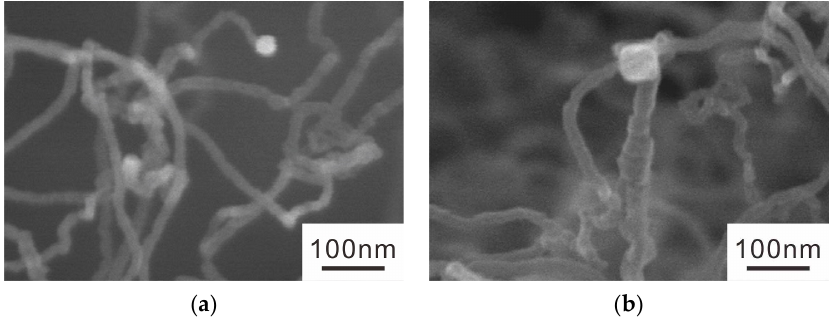
Figure 17. Magnified FE-SEM images of ( a ) thin CNT grafted from thin Ni particle and ( b ) thick CNT grafted from thick Ni particle.